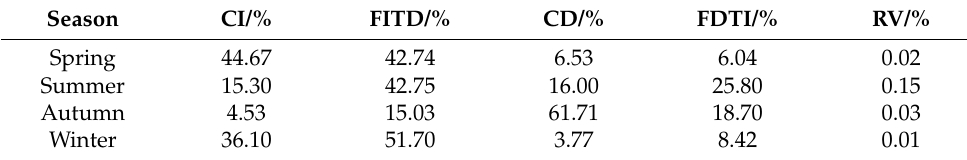
Figure 6. LST direction change prediction. Table 4. LST future change trend statistics table.